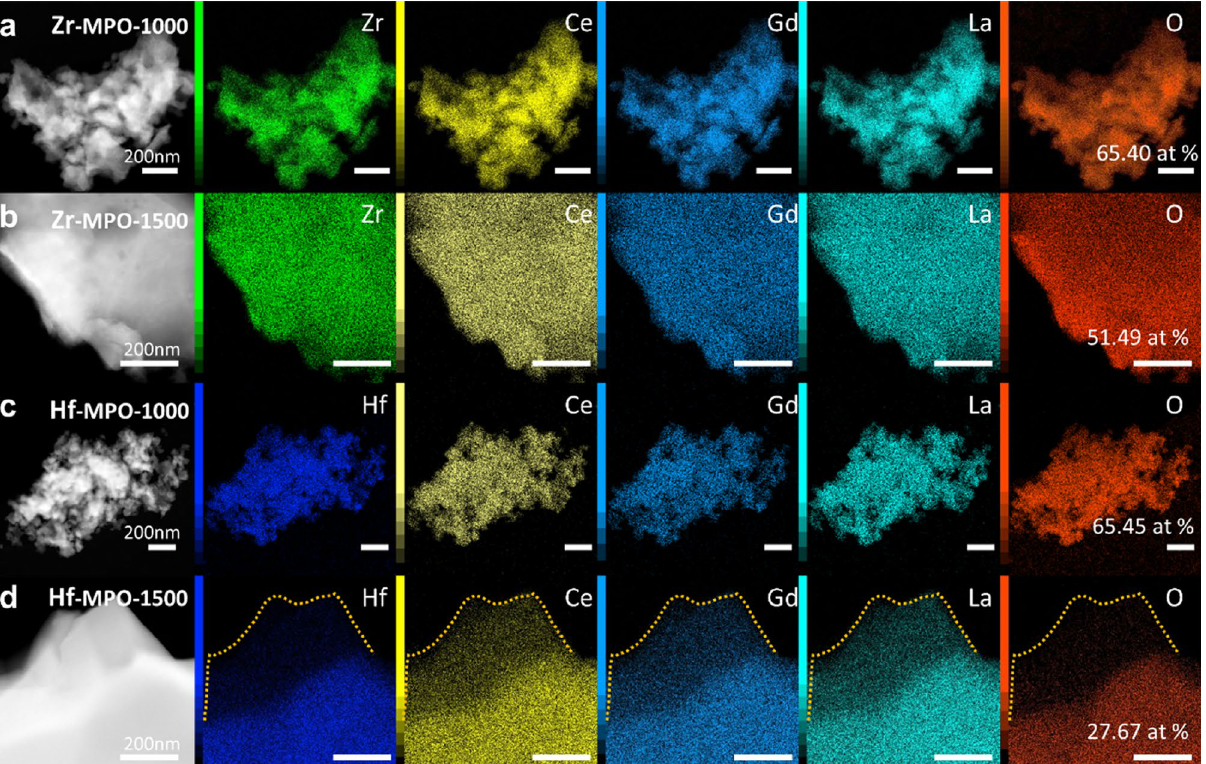
Figure 3. Typical STEM-EDS result of ( a ) Zr-MPO-1000; ( b ) Zr-MPO-1500; ( c ) Hf-MPO-1000 and ( d ) Hf-MPO-1500. The scale bar is 200